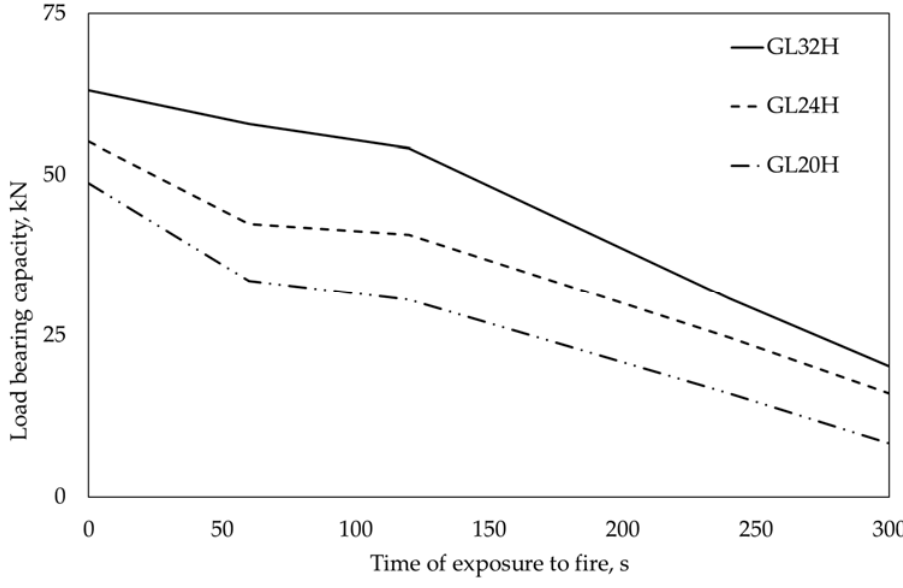
Figure 19. Load ‐ bearing capacity. Figure 19. Load-bearing